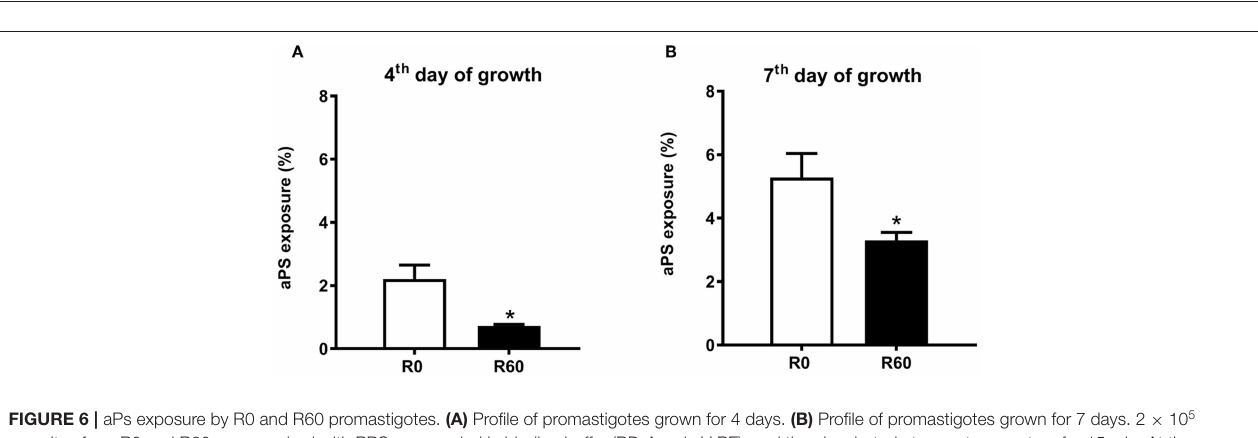
and 7th days of axenic growth ( Figures 6A,B ). Overall, lower aPS levels were presented by R60 than R0. This finding, in conjunction to the metabolomic data, may suggest that aPS